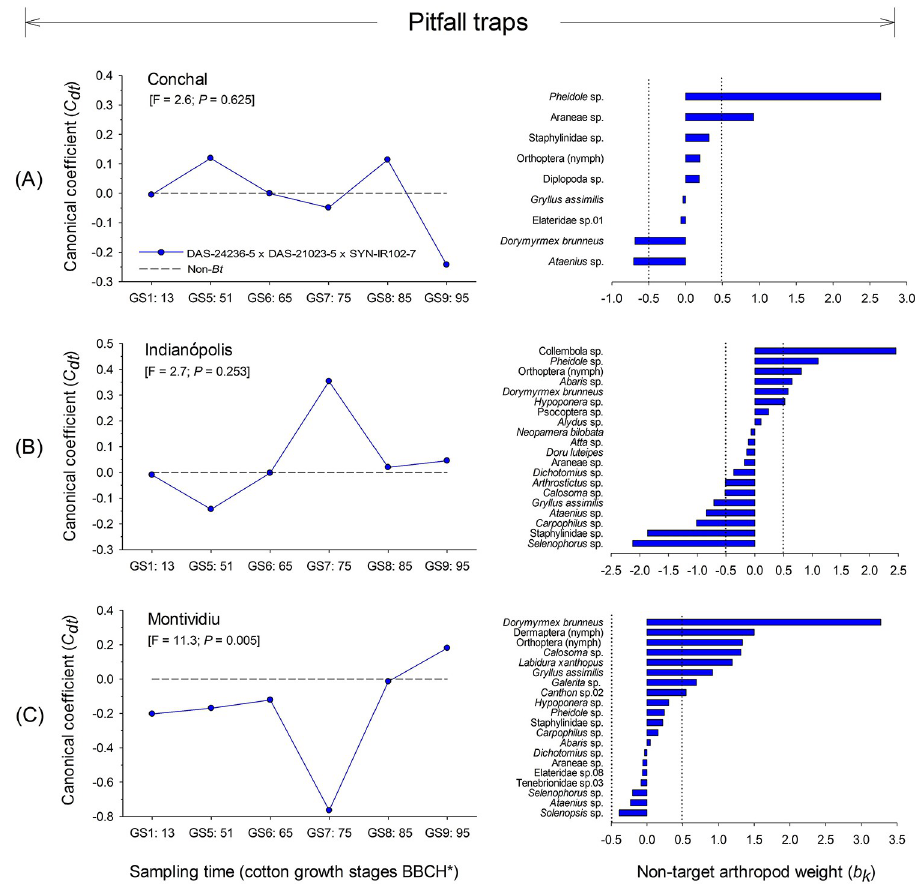
Fig 9. Principal response curves (PRCs) and taxon weights of ground-dwelling arthropod populations collected via pitfall trapping from DAS-21023-5 × DAS-24236-5 × SYN-IR102-7 Bt cotton compared with a non- Bt variety at three sites in Brazil (2014/2015 cropping season). Dotted line indicates the response within the non- Bt cotton entry. If a significant P-value was detected ( < 0.05, Monte Carlo test), taxa with positive weights followed the PRC pattern, whereas those with negative weights showed the opposite pattern. Taxa with weights between approximately -0.5 and 0.5 did not contribute significantly to the overall pattern. If a P-value was non-significant, species patterns were random in relation to treatments. � Phenological growth stages of cotton classified according to Munger et al.